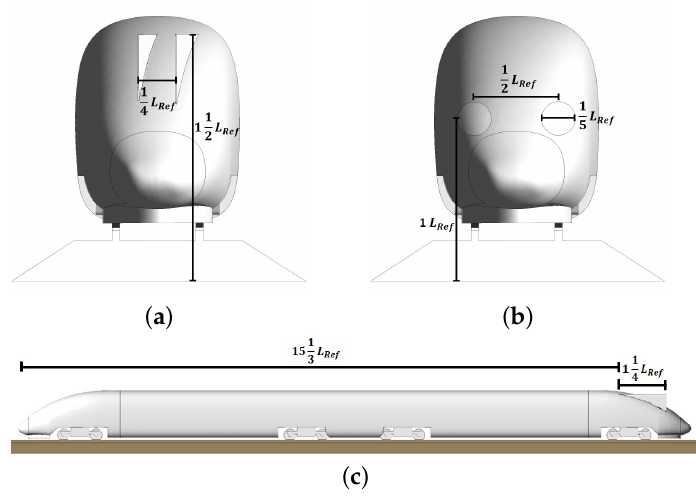
Figure 2. Rear views of ( a ) parallel fins at seven degree orientation angle and ( b ) circulation injection vents. ( c ) Side view of fins before rotation is